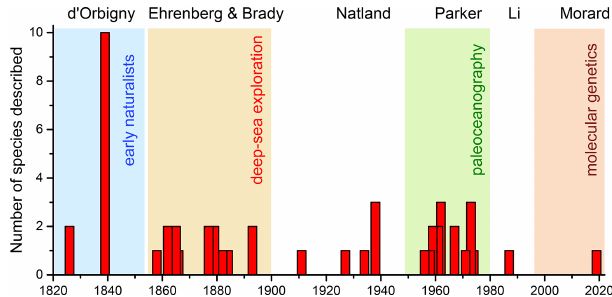
Figure 1. Timeline of the year of original description of 50 ex- tant planktonic foraminifera species and subspecies accepted in this study (including the subspecies G. ruber albus described in 2019), highlighting the main “eras” of taxonomy, with names of represen- tative